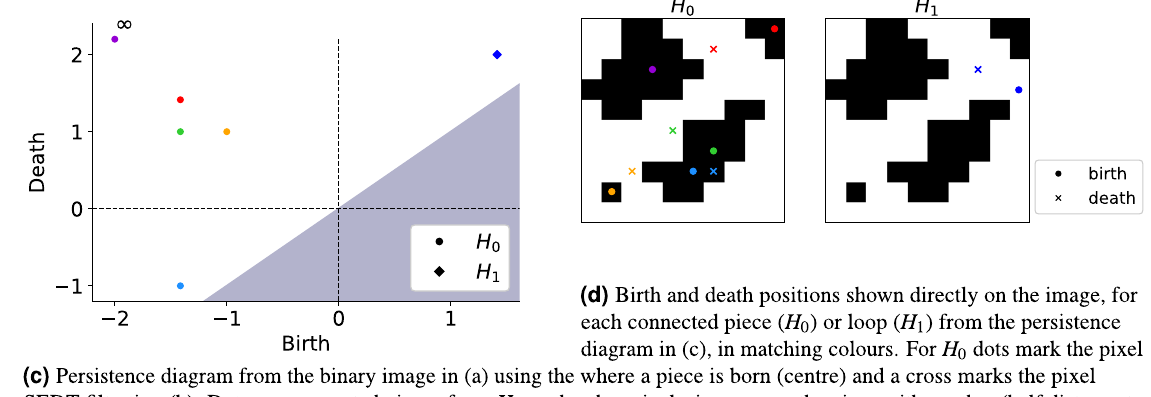
Figure 3. Cubical SEDT filtration of a binary image and persistent homology diagram.